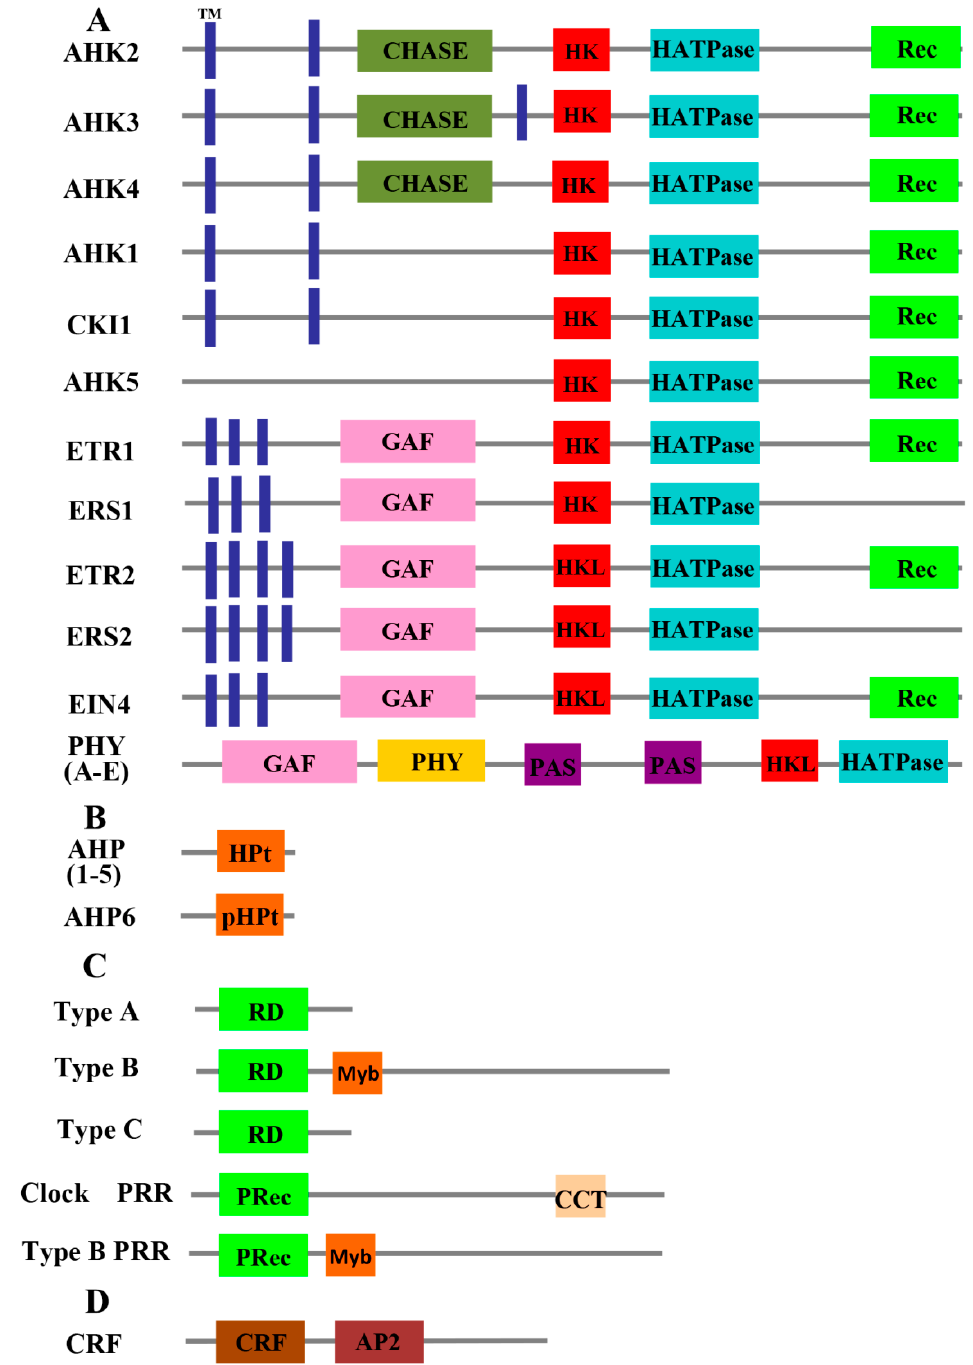
Figure 2. Representative domain structures of Arabidopsis two-component signaling elements. ( A ) Domain structures of HKs. ( B ) Domain structures of Hpts. ( C ) Domain structures of RRs. ( D ) Domain structures of CRFs. TM, transmembrane; CHASE, cyclases/histidine kinases associated sensing extracellular; HK, histidine kinase; HATPase, histidine adenosine triphosphatase; Rec, receiver; GAF, cGMP-regulated phosphodiesterases and adenylate cyclases of Anabaena and the bacterial transcription factor FhlA; HKL, histidine kinase like; PHY, phytochrome; PAS, Per/Arndt/Sim; HPt, histidine-containing phosphotransfer; pHPt, pseudo histidine-containing phosphotransfer; RD, receiver domain; PRec, pseudo receiver; CCT, Co, Col and Toc1; CRF, cytokinin response factor; AP2, APETALA 2.